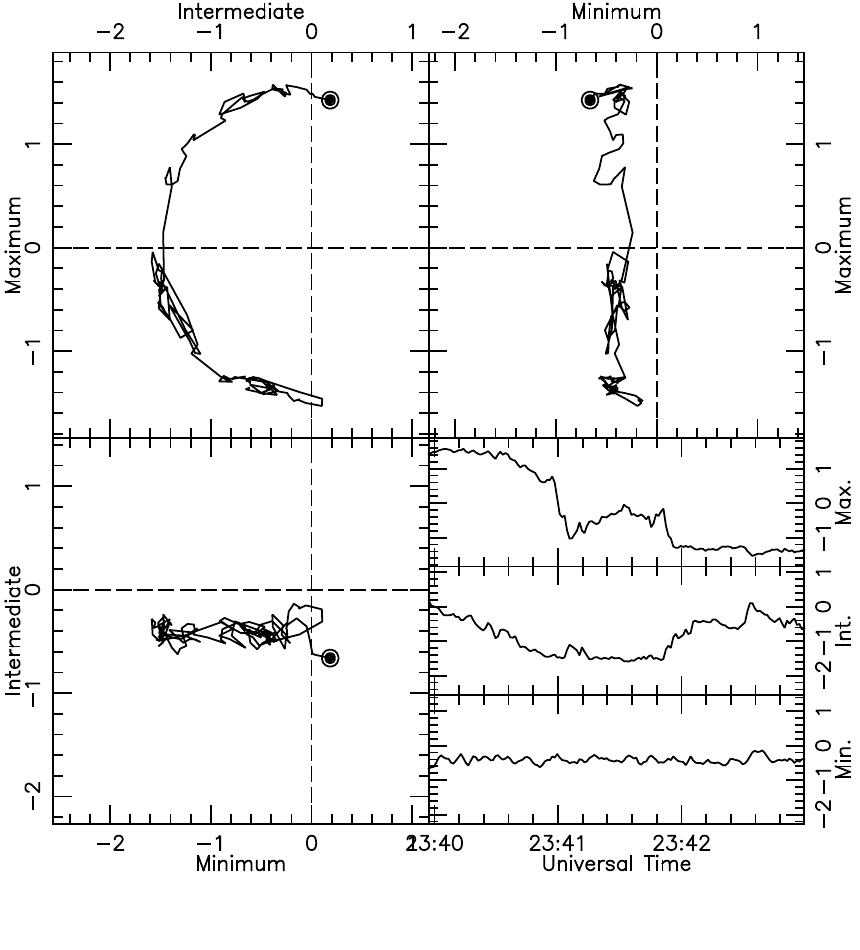
Fig. 9. Ulysses event in Fig. 8: Hodogram for the rapid field rotation only. Resolution is 1 sample/s. The eigenvalue ratio is λ 2 /λ 1 = 29; further details from the MVAB calculation are given in Table